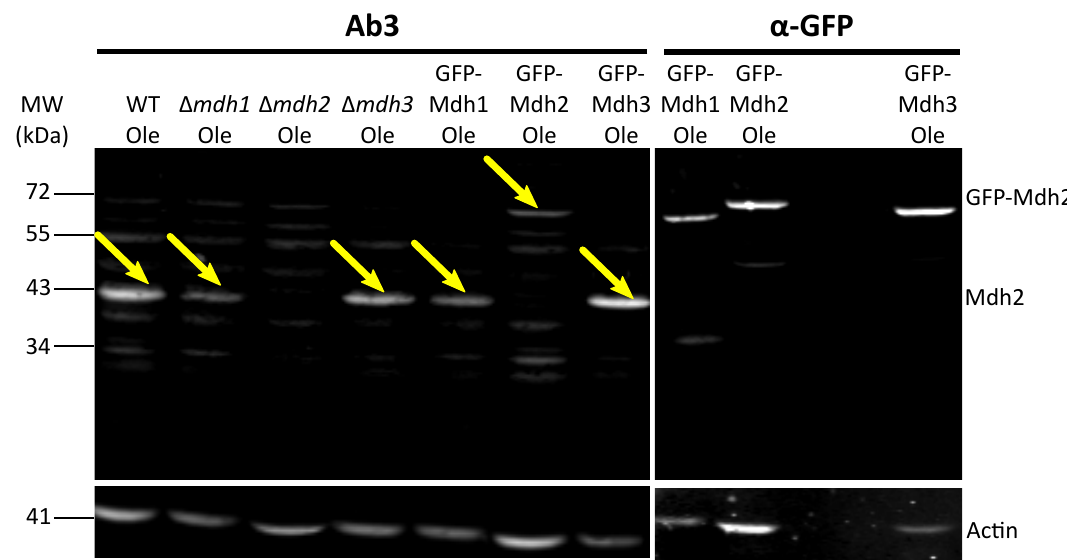
Figure 4. Antibody 3 recognizes Mdh2 in Δ mdh1 and Δ mdh3 cells extractions. Western blot analysis was done on protein extractions from different strains grown on oleic acid (Ole) using antibody 3 and an anti-GFP antibody. As shown in Figure 3, this antibody does not recognize Mdh2 in Δ mdh2 strain or in cells grown on glucose but does recognize Mdh2 in Δ mdh3 cells grown on oleic acid. Here we show that antibody 3 also recognizes Mdh2 in Δ mdh1 cells grown on oleic acid. Actin was used as a loading control. Yellow arrows indicate bands corresponding to Mdh2. We saw that antibody 3 specifically recognizes Mdh2 and not Mdh3 in two experiments and that antibody 3 does not recognize Mdh1 in one